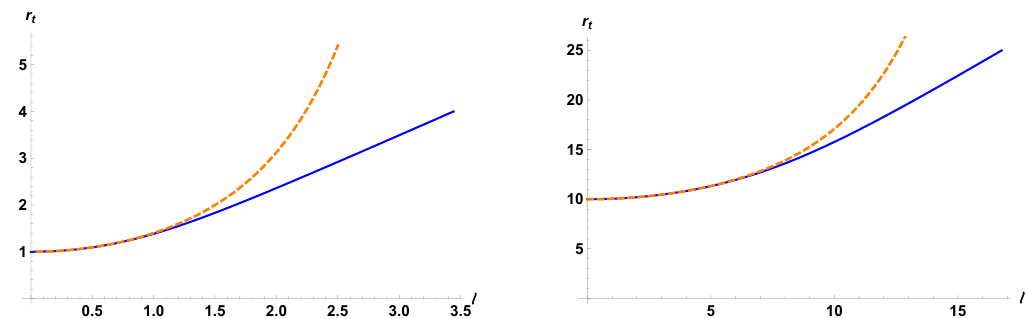
Figure 7 . The turning point r t as a function of ‘ for different values of the cutoff: Left ) r c = 1 and d e = 3 Right ) r c = 10 and d e = 4 . The solid blue curves are based on eq. (3.16) and the dashed orange curves are based on the perturbative expression in eq. (3.25) which is valid for very small entangling regions, ‘ (cid:28) r . c